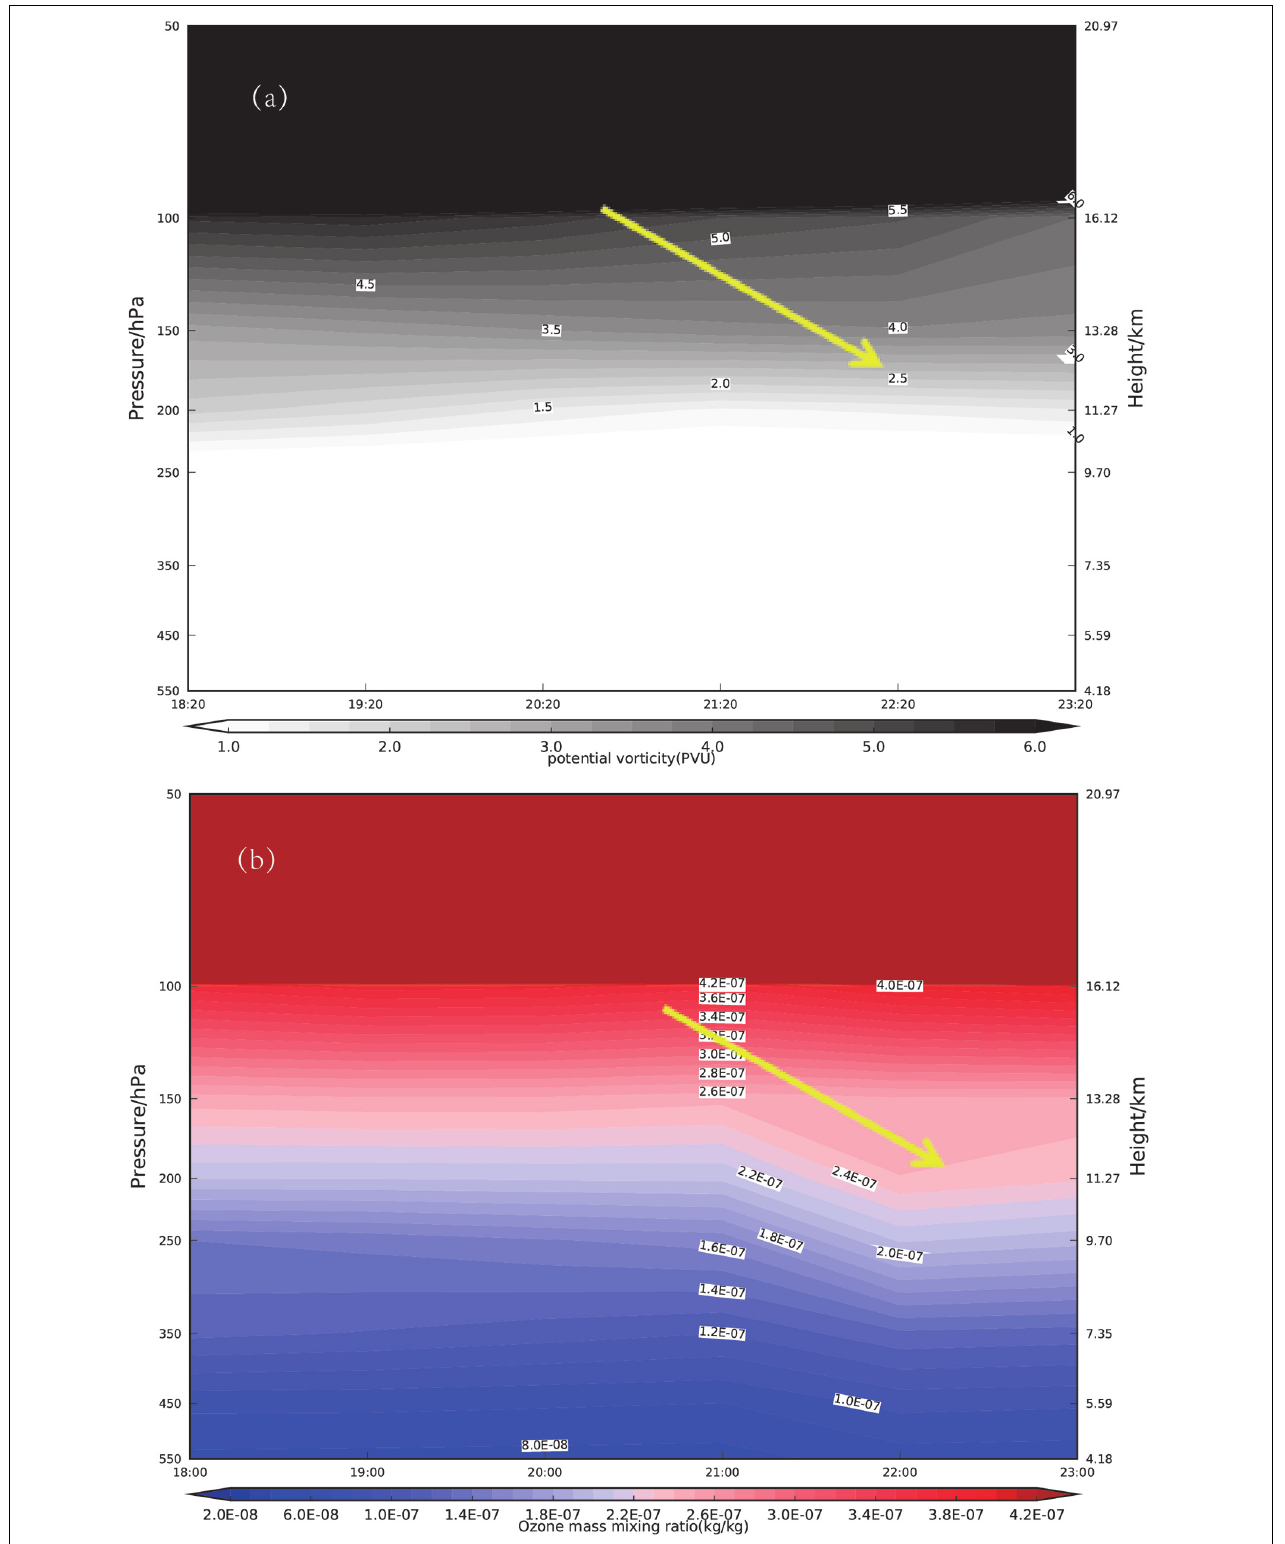
FIGURE 13 | The time evolution of (a) the vertical distribution of potential vorticity (PV) simulated by WRF and (b) ozone mixing ratios from ERA5 (also Figure 7B ) for the period 18:00–23:00 on 3 May, 2014 above 28 ◦ N, averaged between 92.5 ◦ E–98.5 ◦ E.